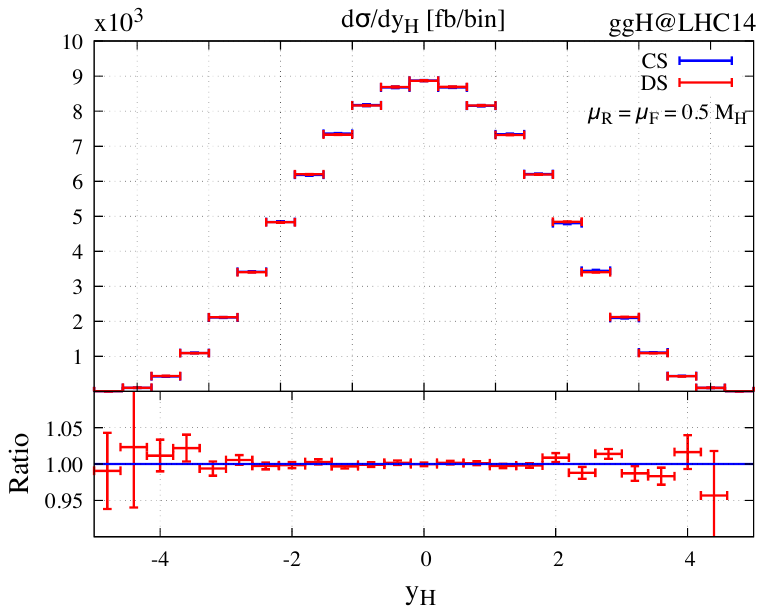
Figure 10. Rapidity distribution of the Higgs boson in proton-proton collisions at 14 TeV center- of-mass energy ( gg -channel only). The renormalization and the factorization scale are both equal to µ = m 2 = 62 . 5 GeV. The Dual Subtraction (DS) results are shown in red, while the Catani- H / Seymour (CS) ones in blue. The error bars correspond to the statistical error given by the Monte Carlo integration performed with the same